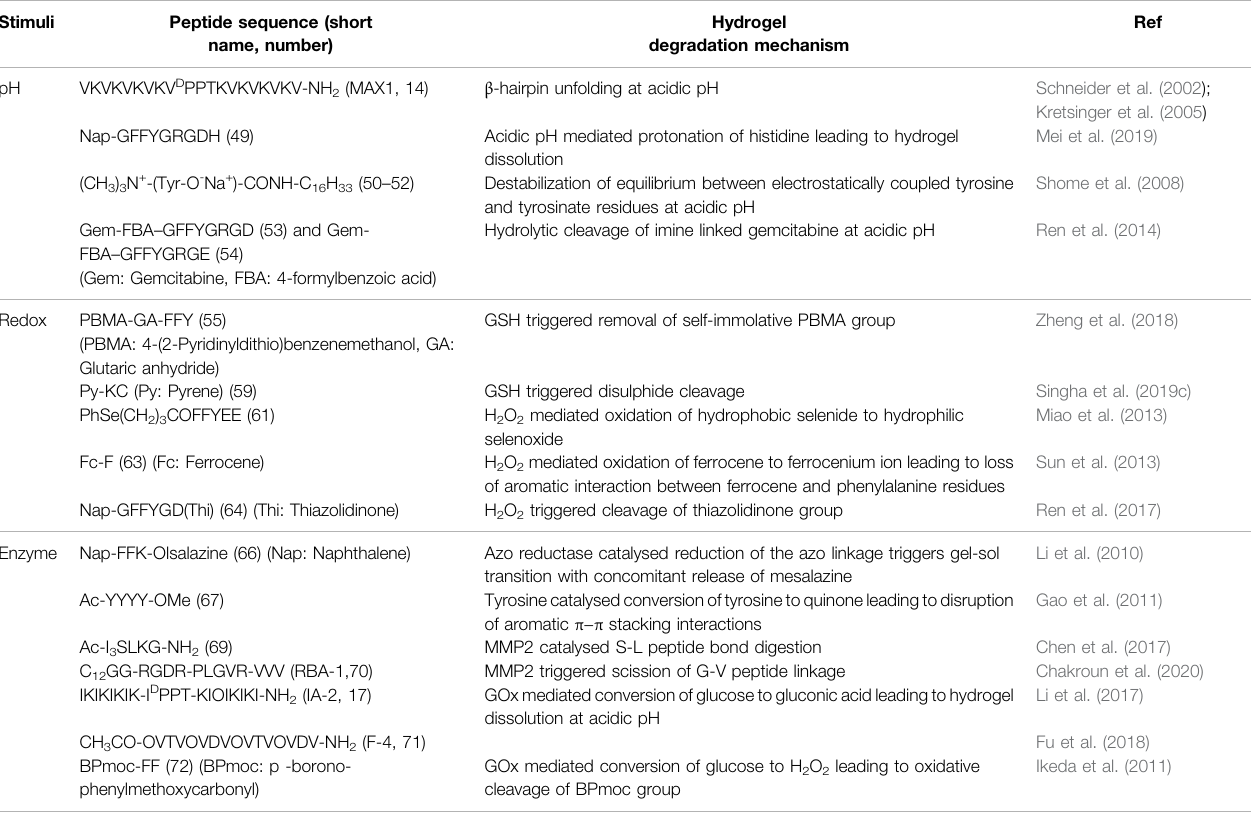
TABLE 1 | List of different stimuli responsive peptide hydrogelators. Stimuli Peptide sequence (short name, number)